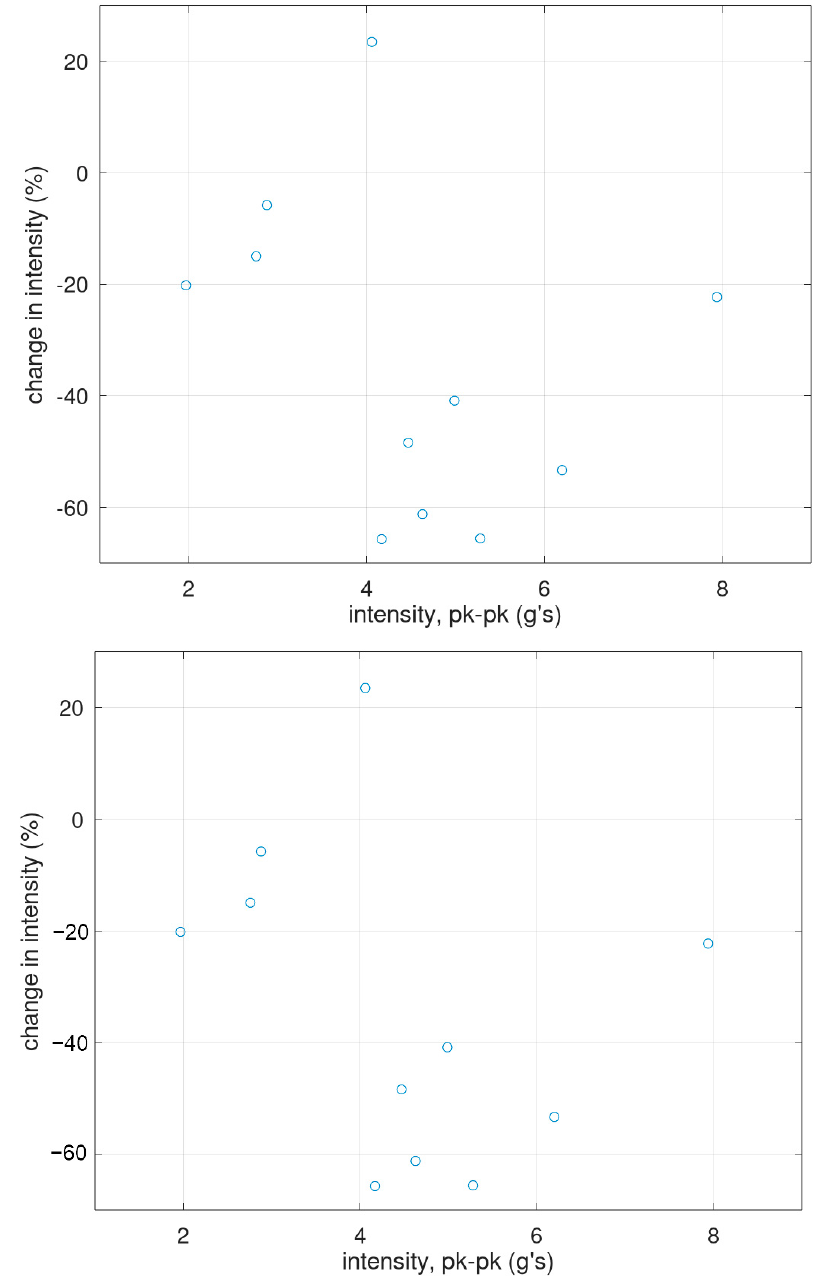
Figure 7. Change in vibration intensity from the free vibration to the constrained vibration setup. The y -axis shows the intensity for the free vibration setup. The x -axis shows the change in intensity between the two setups, relative to the free vibration setup. A negative number indicates a decrease.